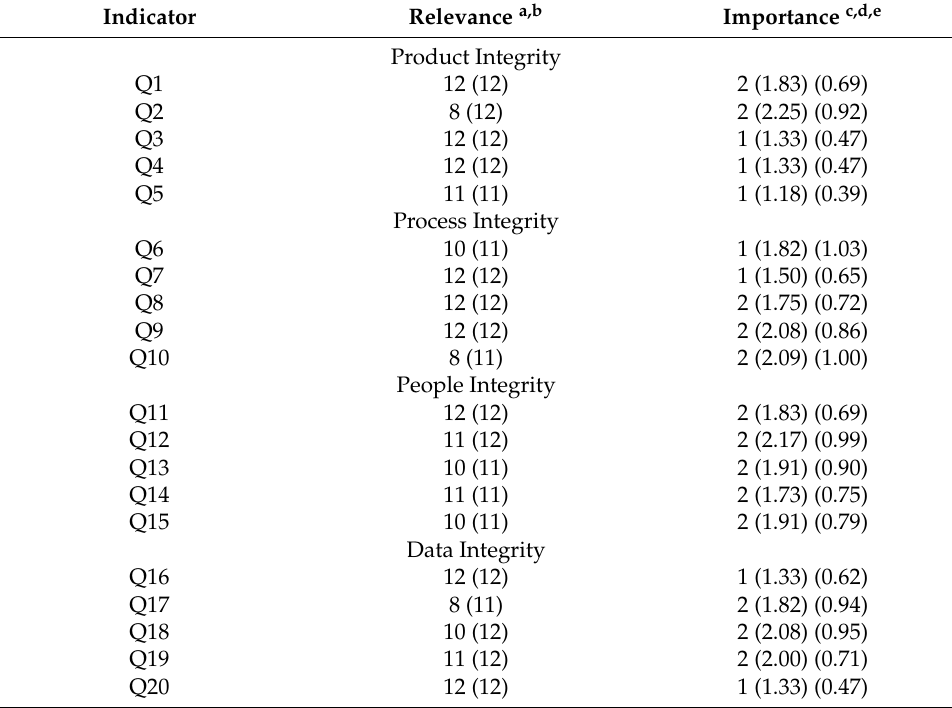
Table 2. Expert validation results based on the relevance and importance rating of the food integrity climate self-assessment tool